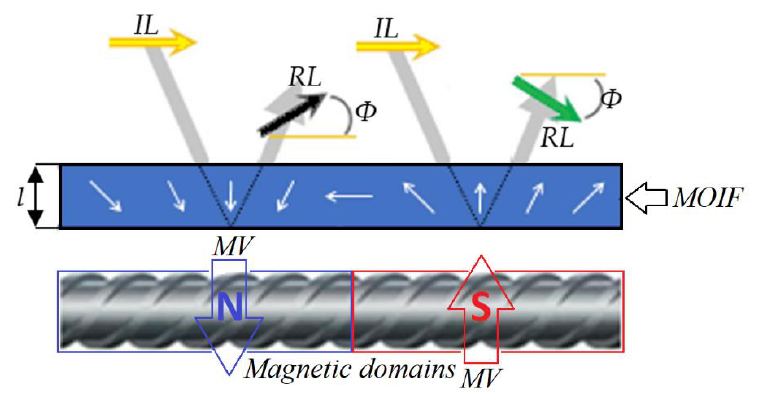
Figure 7. Operating principle of the MOIF. MOIF — Magneto-Optical Indicator Film (sensor); MV — Magnetic Vector; IL — Polarization Plane of Incident Light; RL — Polarization Plane of Reflected Light; Φ — Angle of Faraday rotation.